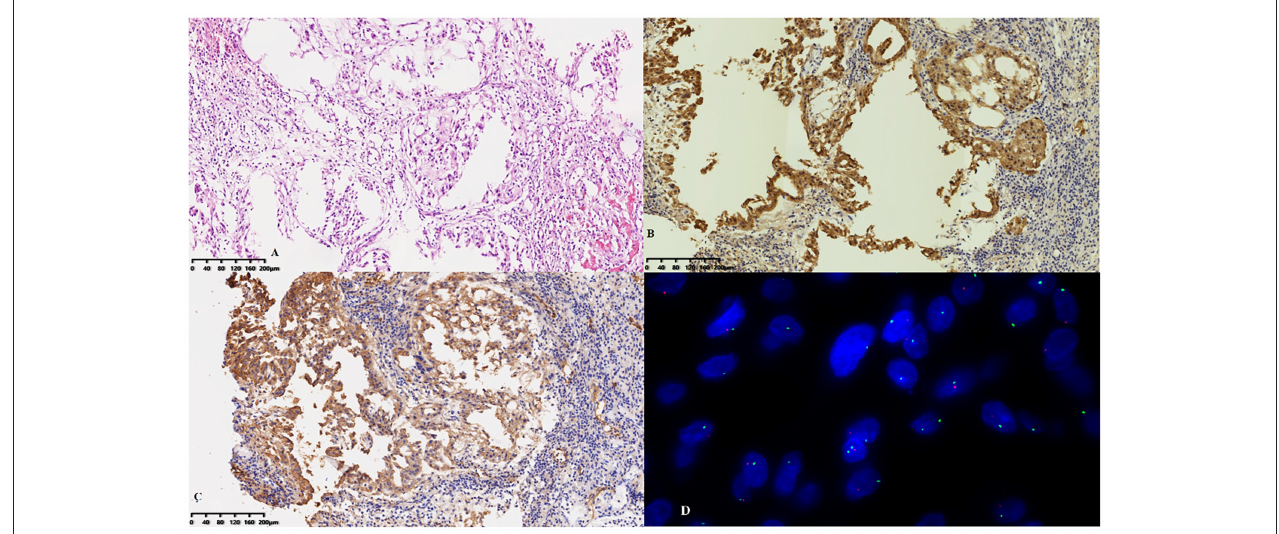
FIGURE 4 | Pathological features. (A) Hyperplastic epithelioid cells were arranged in sheets on the surface of the pericardium with an inflammatory background. The cells were positive for (B) calretinin and (C) D2-40 by immunohistochemistry. (D) CDKN2A (p16) deletion was detected by fluorescence in situ